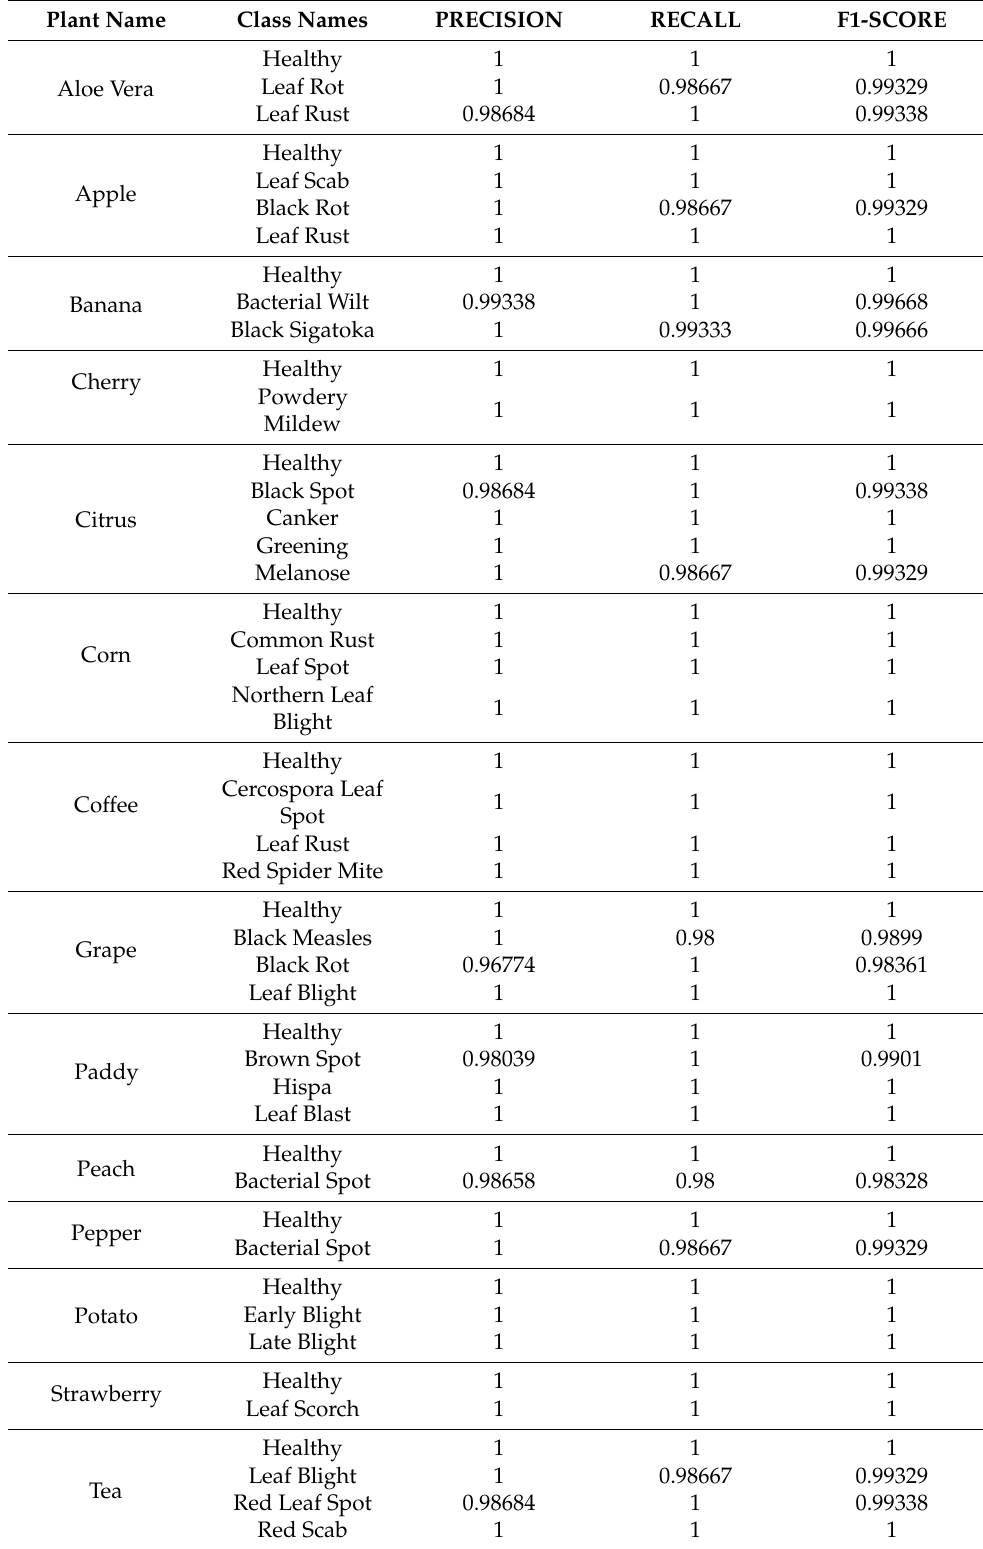
Table 5. Class-wise performance of proposed 14-DCNN